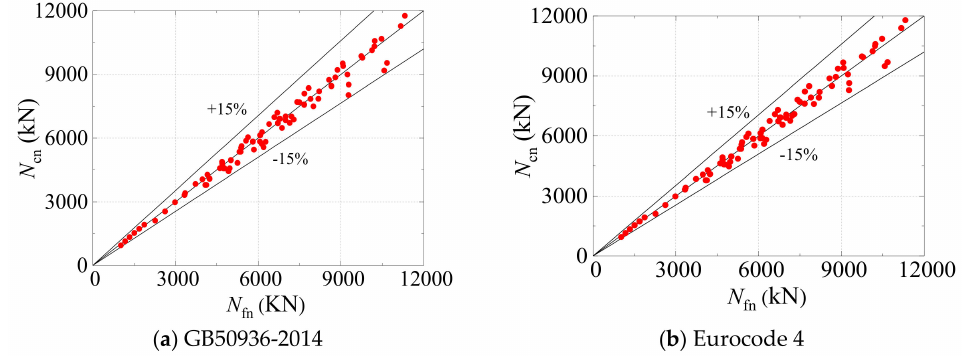
Figure 16. Comparisons between the simulation results from the finite element (FE) model and the calculation results from design formulae for calculating bearing